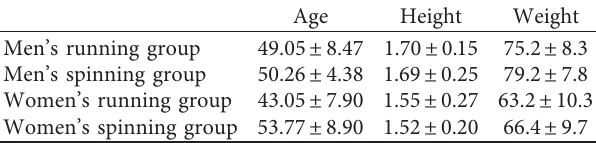
Table 1: Basic physical conditions of the subjects. Age Height